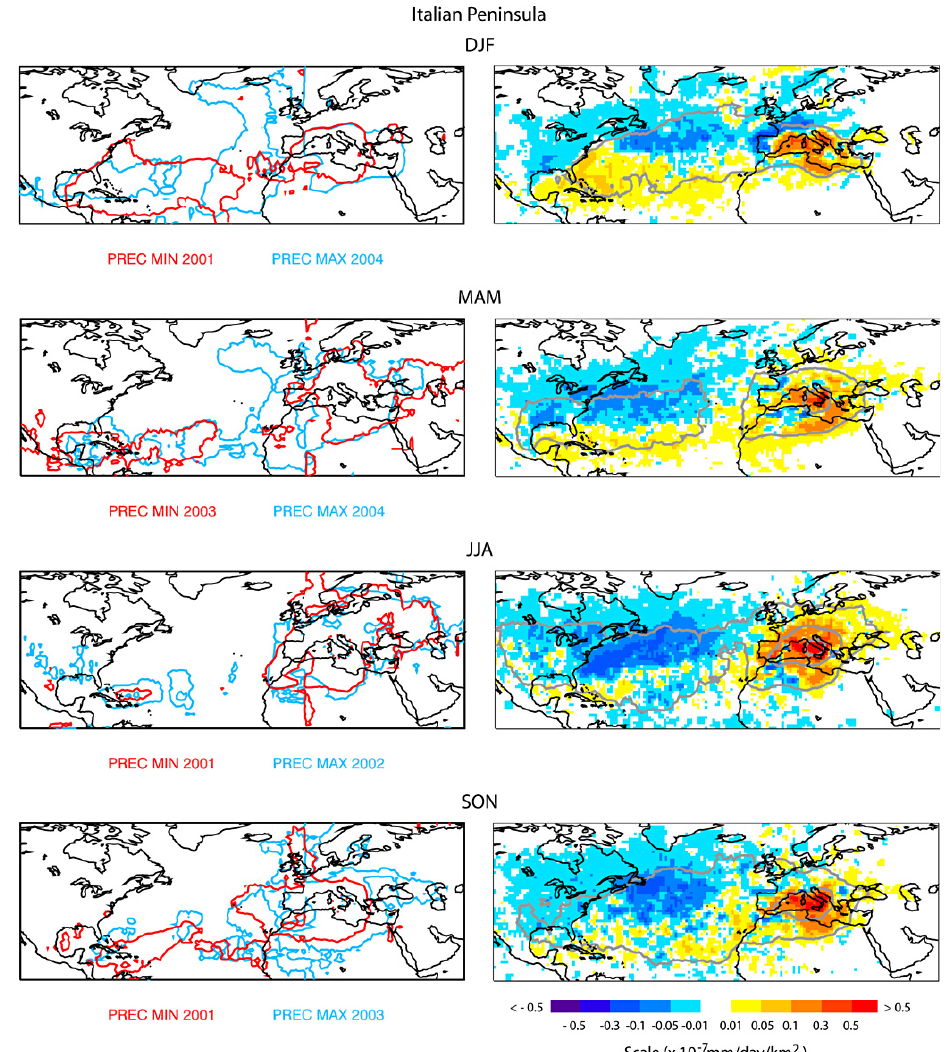
Fig. 4. As Fig. 2, but for the Italian Peninsula (ItP), considering its equivalent area as 205507km 2 .